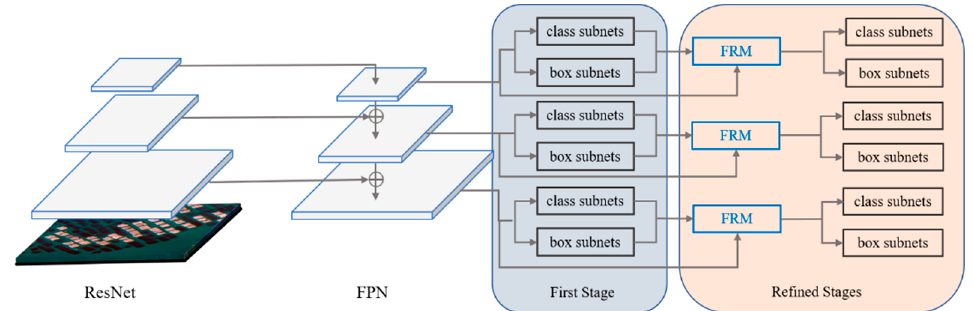
Figure 8. R 3 Det network